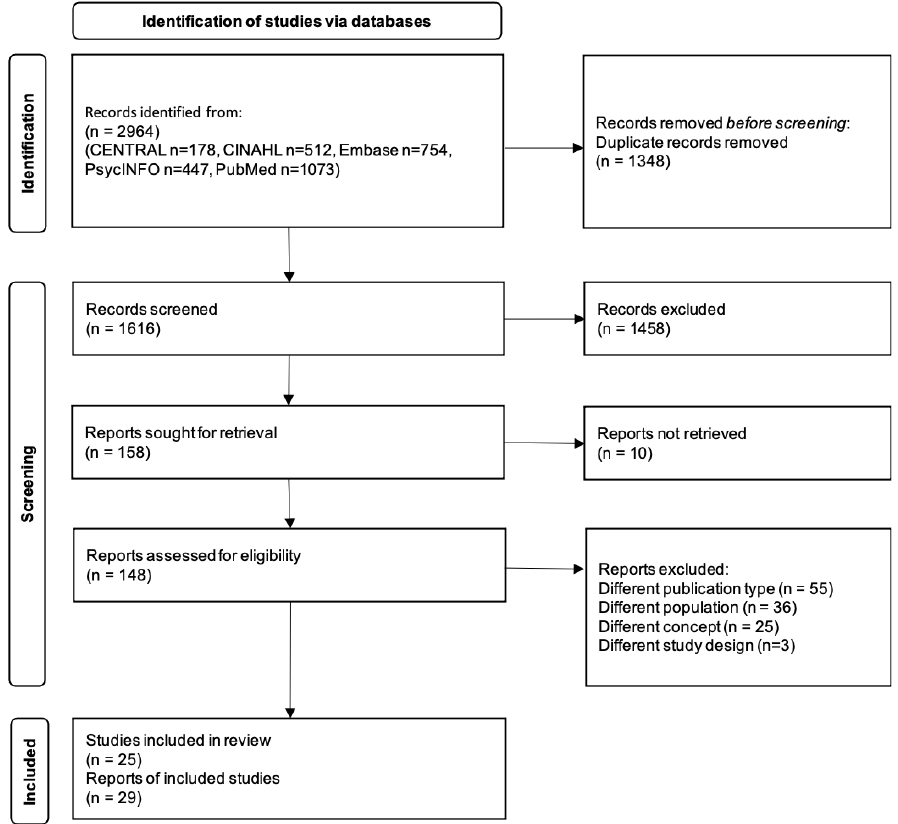
Figure 1. Process of selection